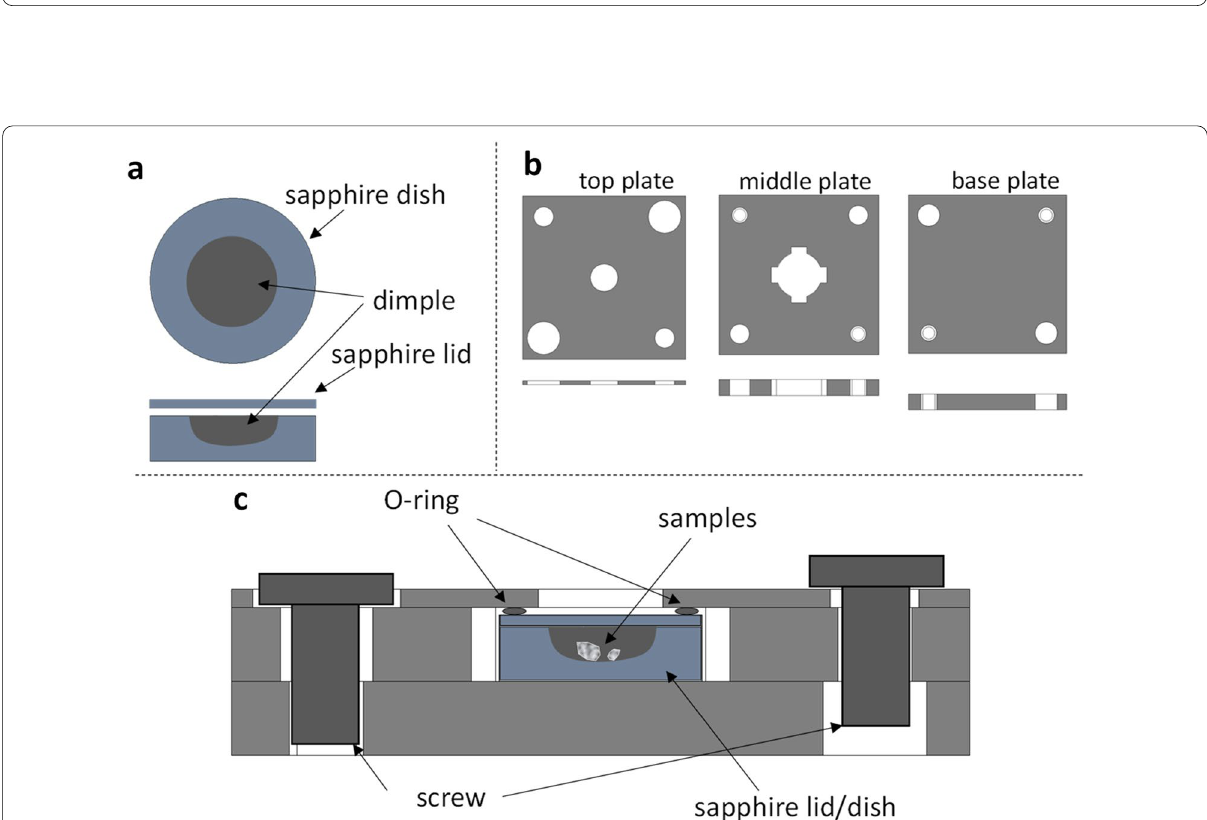
Fig. 12 Schematic diagram of the sapphire container and the metal holder. a . The sapphire dish is 5.5 mm in diameter and 1.5 mm in thickness. The dimple was made by a portable grinder and polished diamond powder. b . The metal holder consists of three parts made of stainless steel, which are easily washed and assembled. c. The samples placed in the sapphire dish were enclosed with the lid and the